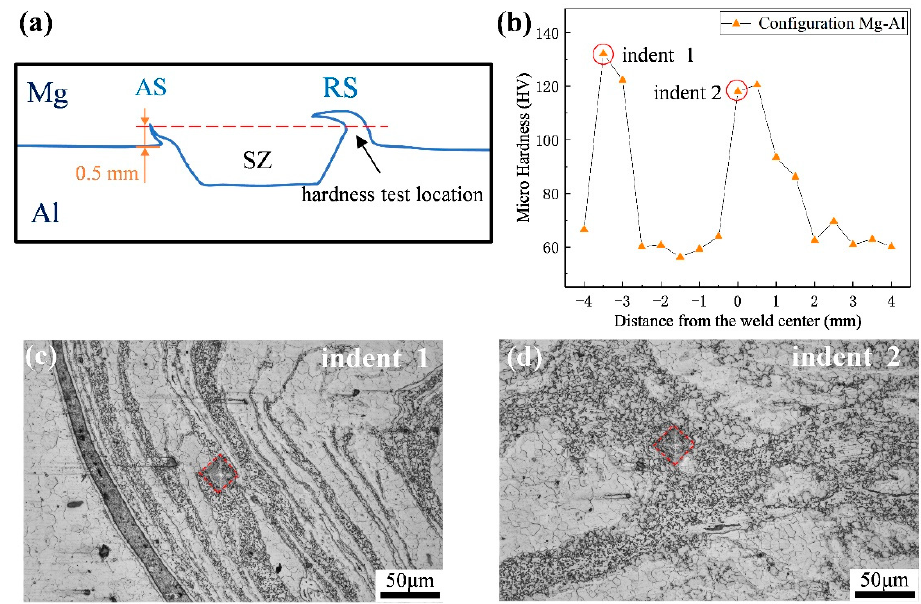
Figure 11. Results of microhardness tests of the joint welded in Configuration Mg-Al at 700 rpm: ( a ) schematic diagram of hardness test location; ( b ) microhardness profiles; ( c ) optical micrograph at indent 1; ( d ) optical micrograph at indent 2.